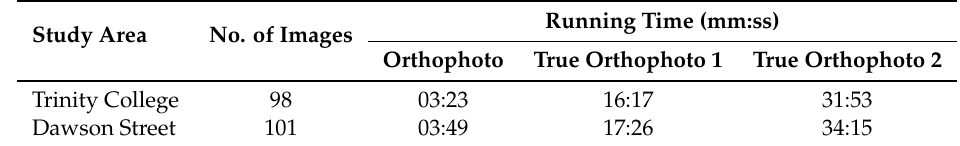
Table 4. Running time of orthophoto generation using the differential rectification technique, and true orthophoto production using the closest visible image and IDW-based spectral balancing